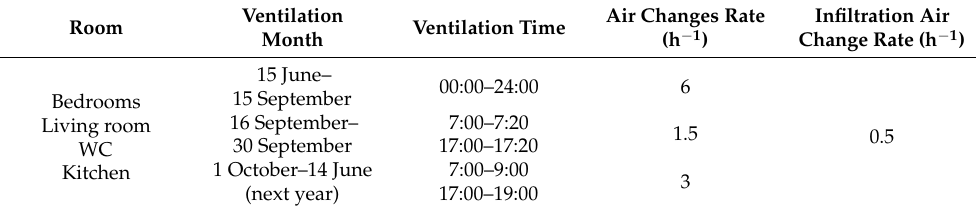
Table 5. Simulation parameters for natural ventilation of windows in Harbin.